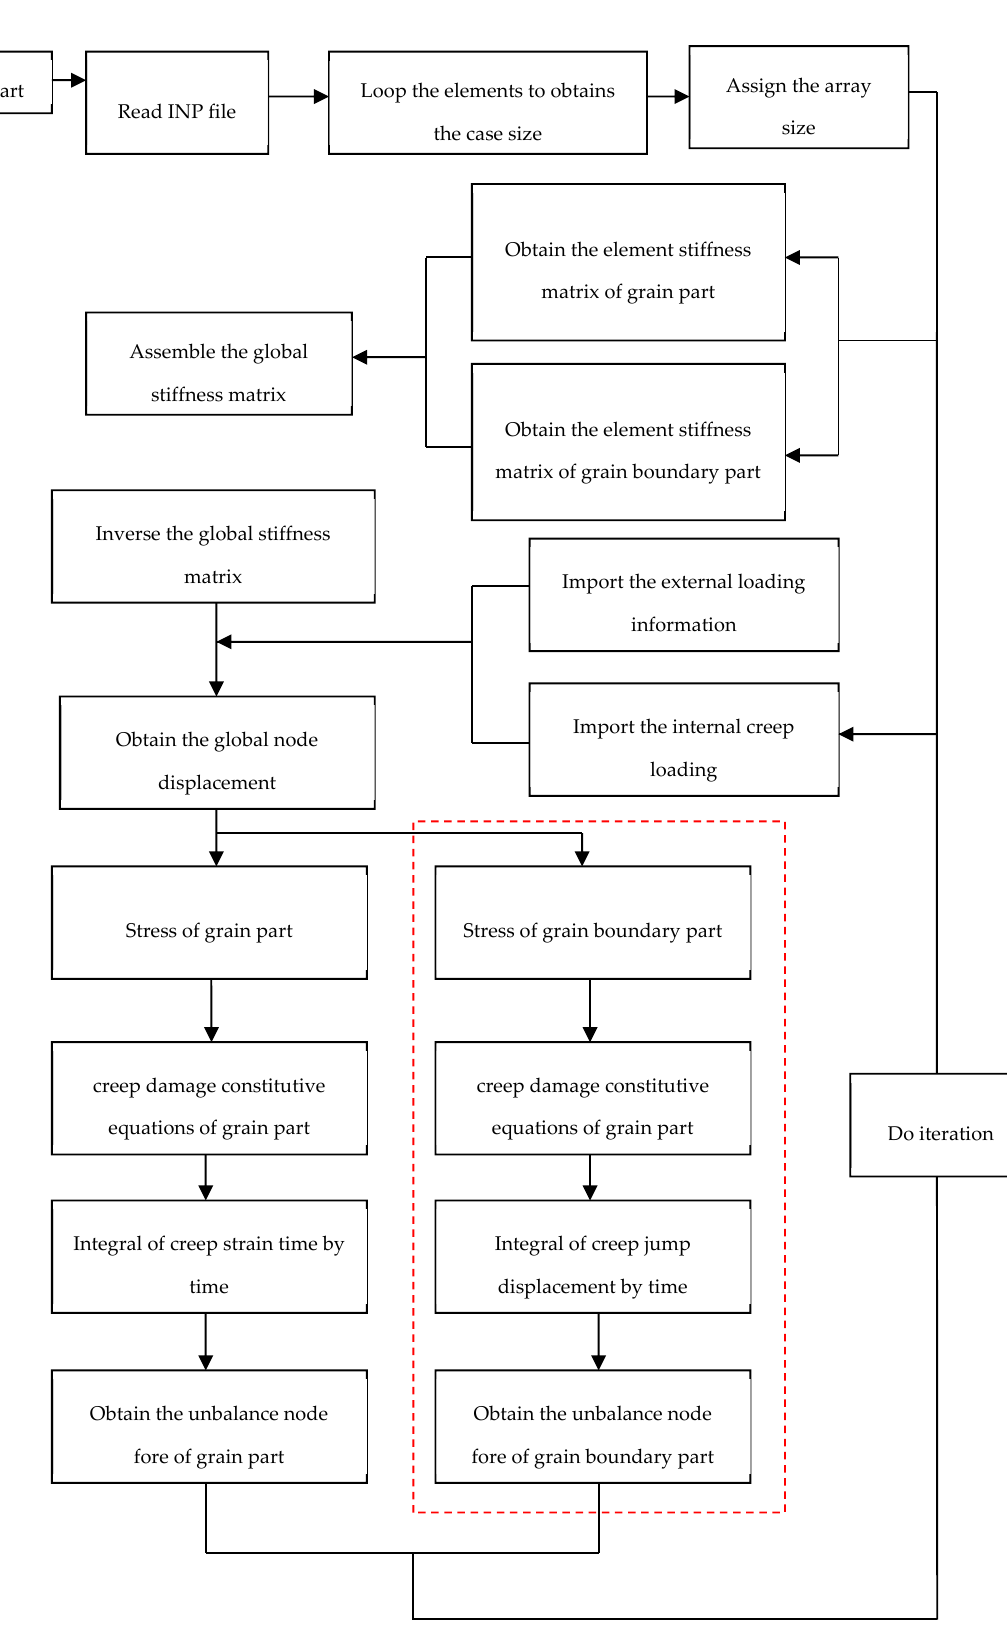
Figure 1. Flow diagram structure of the in-house procedure.